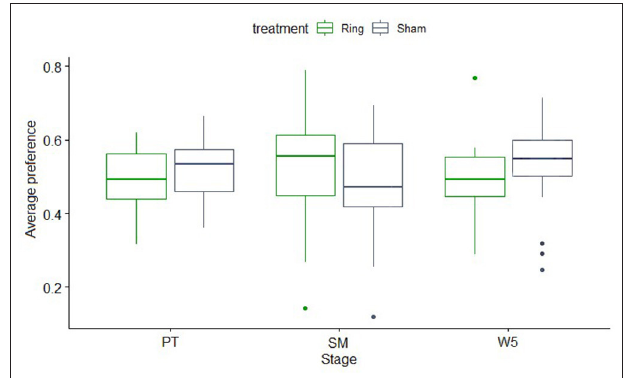
FIGURE 4 | Box and whiskers plot showing the median (line), 25–75% quartiles, maximum and minimum of the average preference indices for the Ring ( n = 15) and Sham ( n = 16) treatment groups across the different periods of the experiment. PT, preference test; SM, self-medication phase; W5, preference test 5 weeks post